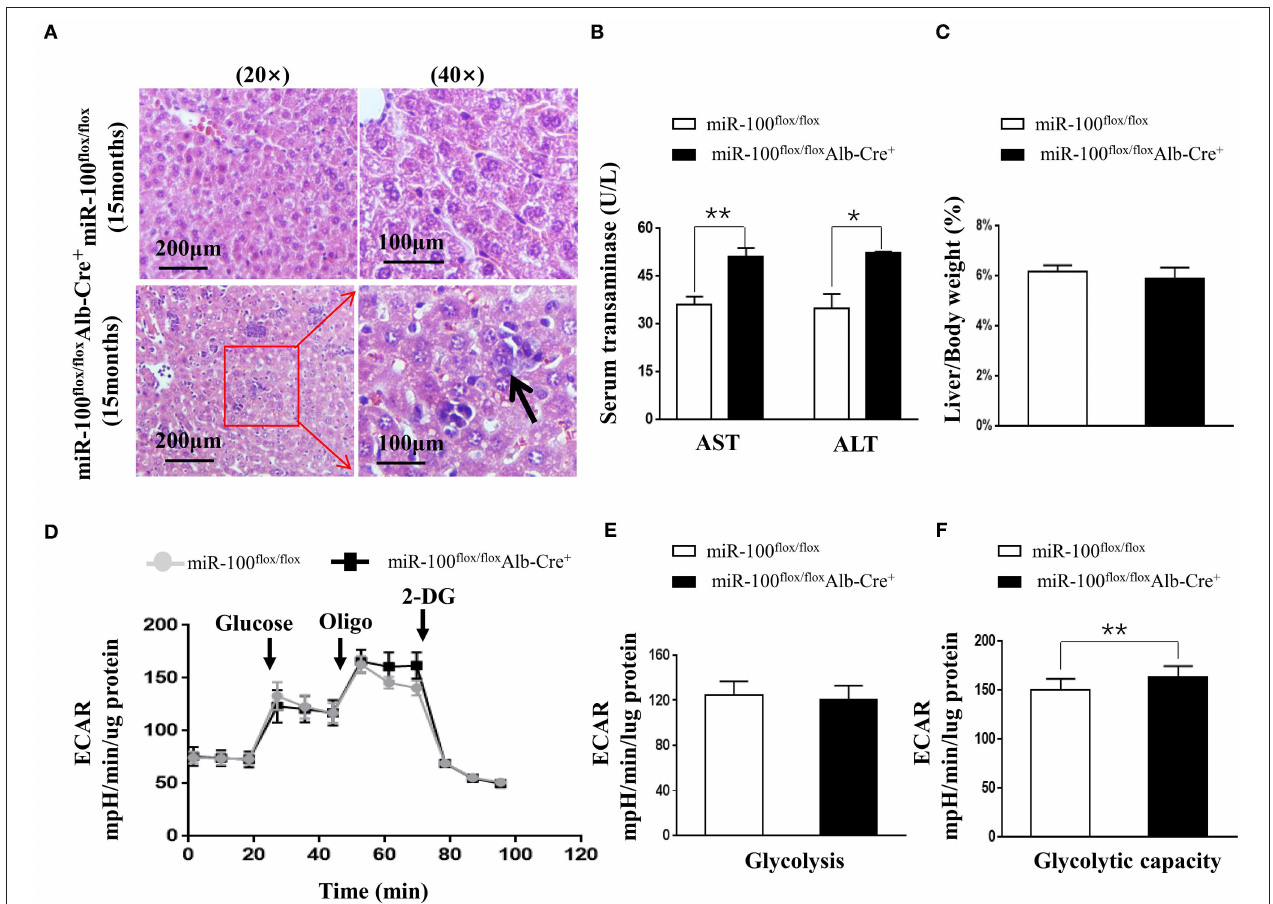
FIGURE 5 | Phenotype analysis of the aged (15 months) hepatocyte-specific miR-100 deletion mice. (A) Representative HE staining of liver sections from each group were shown. Scale bars represent 200 µ m (left) and 100 µ m (right). Black arrows indicate inflammation foci and the hepatocytes with the larger nuclei. (B) Transaminase activity and (C) LW/BW ratios of miR-100 flox / flox Alb-Cre + and miR-100 flox / flox littermates were measured. (D–F) ECAR were measured in real time in a Seahorse XF bioenergetic assay. (D) Average ECAR was calculated during the treatment of glucose, oligomycin, 2-DG as indicated. (E) Glycolysis and (F) glycolysis capacity were indicated. A total of 3 × 10 4 hepatocytes from the 15-months-old miR-100 knock-out mice and control mice ( n = 3) seeded for 24h. Mean ± SEM is representative of 3 independent experiments carried out in triplicate. * P < 0.05, ** P < 0.01 shows significant difference from the control mice after addition of oligomycin (Student’s unpaired t test,